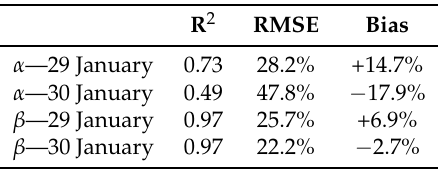
Figure 5. Scatter plots of α p and β p measurements with different wavelength pairs, for 29 January (top panels) and 30 January (bottom panels). Table 3. Statistical parameters for the comparison of α and β with different wavelength pairs (440/1020 nm with respect to 440/870